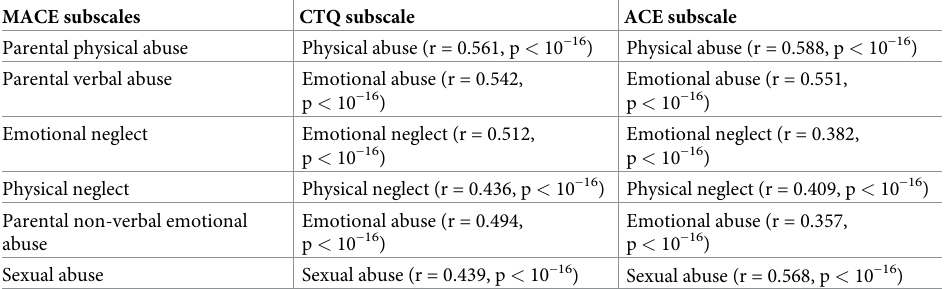
Table 13. Pearson correlation coefficients between matching subscales of MACE and CTQ / ACE.